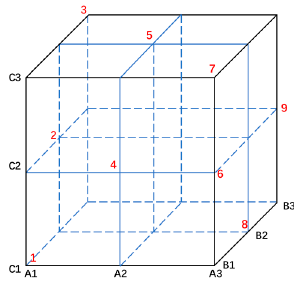
Figure 10. Distribution of the nine cases. Table 6. Analysis of variance for the ice resistance.